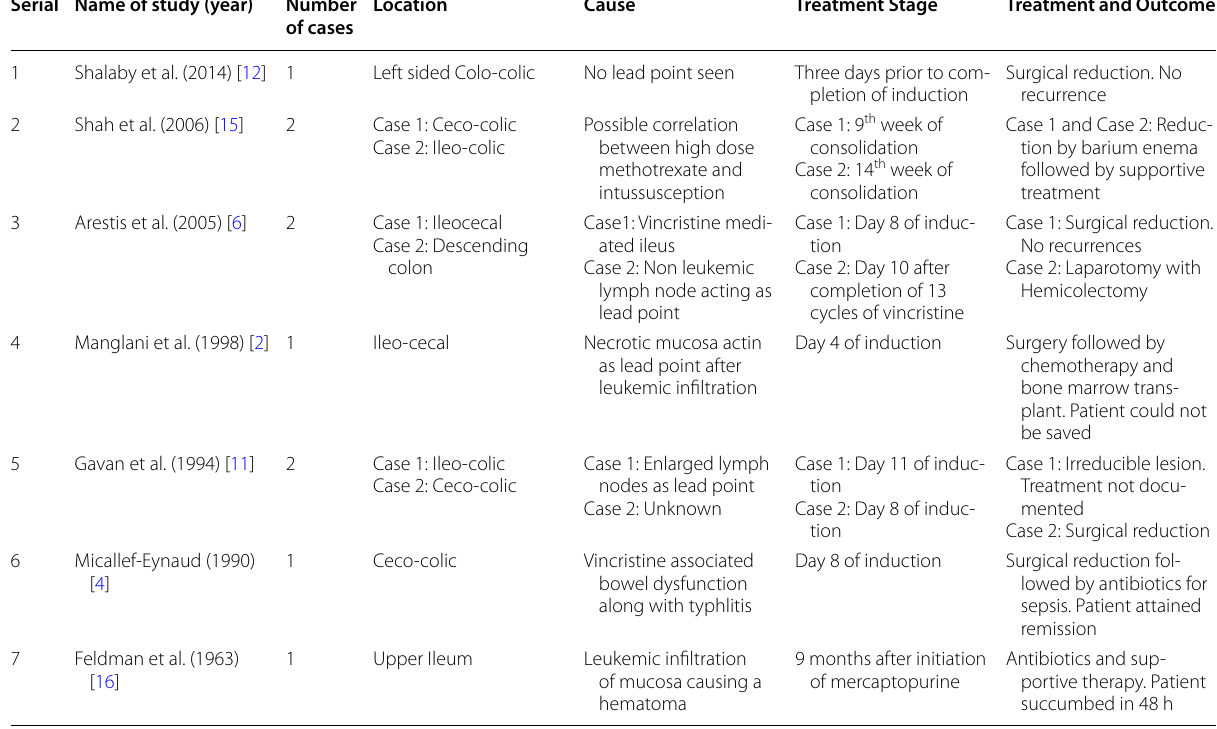
Table 1 Comparison of different reported cases of intussusception in children with Acute Lymphoblastic Leukemia Serial Name of study